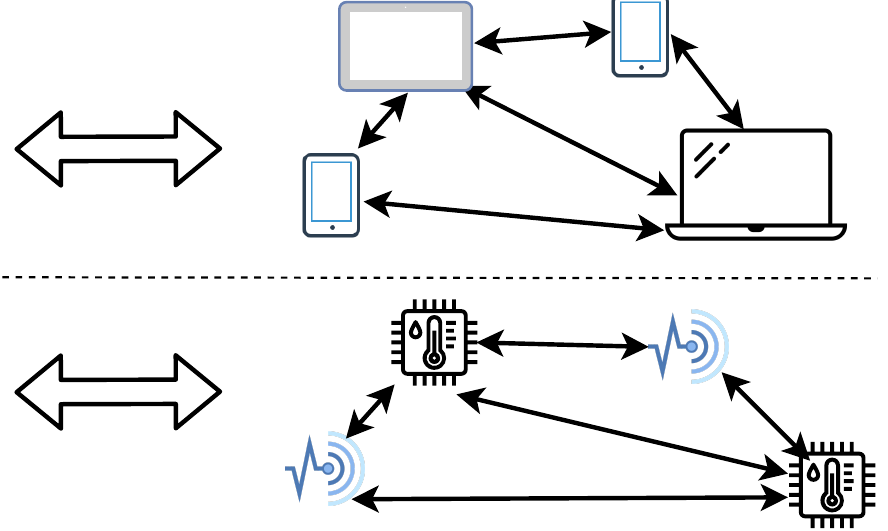
Figure 2. Horizontal scalability with distributed approach achieved by offloading to other devices on the same architectural